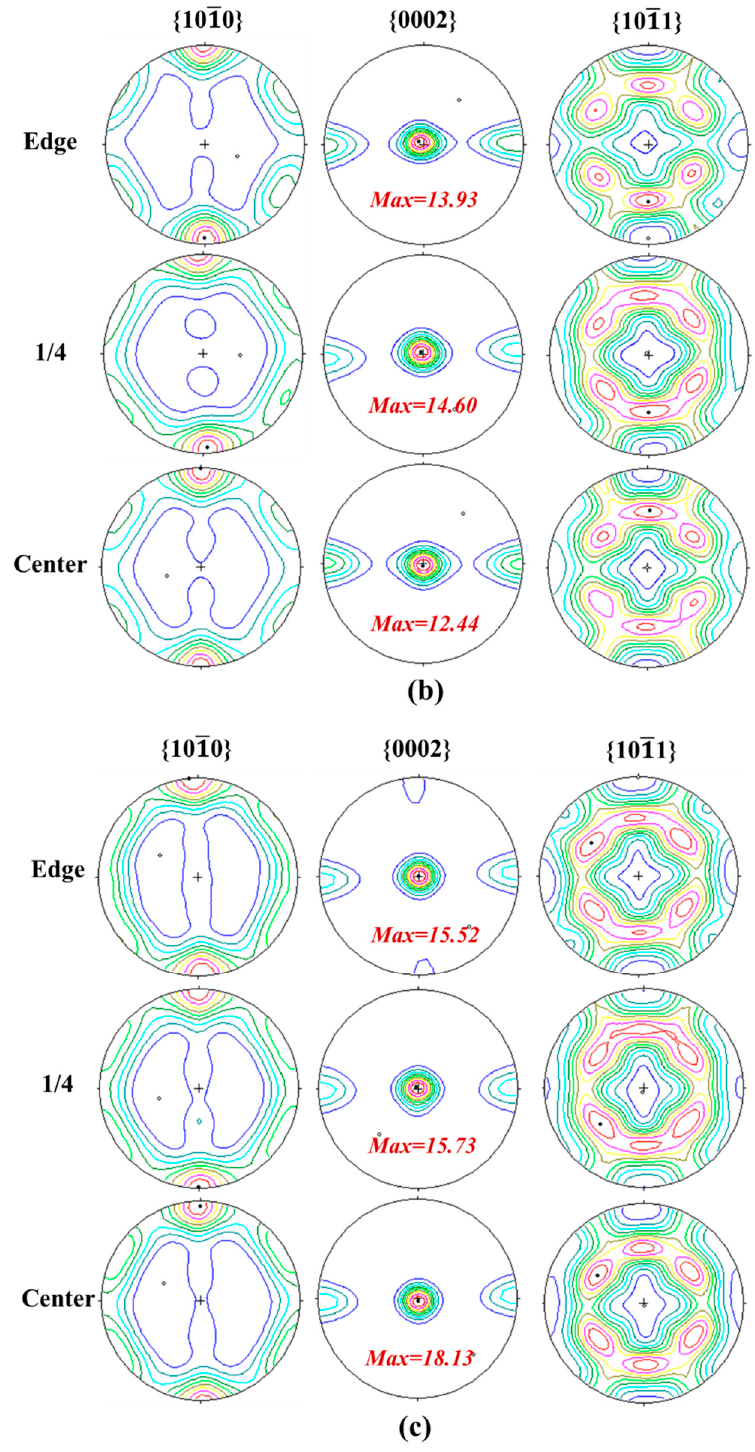
Figure 7. (10–10), (0002) and (10–11) pole figures obtained by neutron diffraction: ( a ) AZ31; ( b ) AZ81; and ( c ) AZ91 sheets.